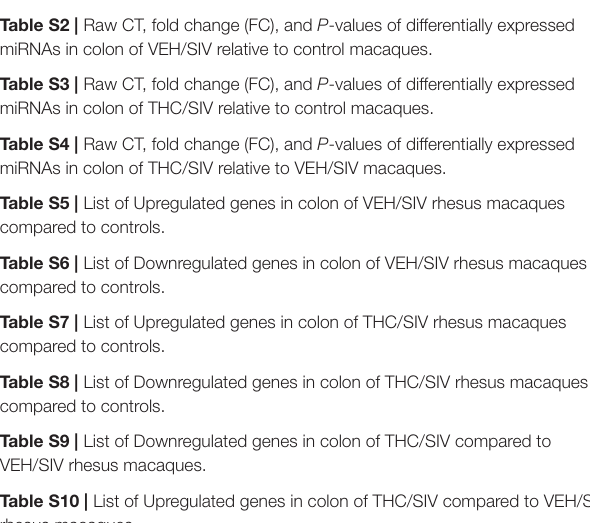
increase in CD8 + T cell